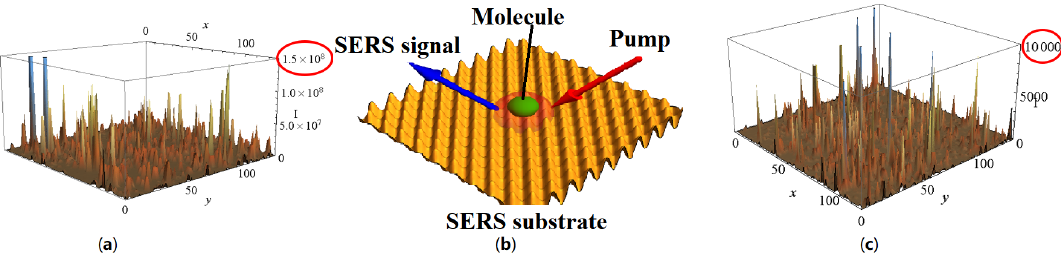
Figure 5. Schematic picture of SERS effect, see ( b ); incident light excites the collective plasmon field in semicontinuous metal film (see c ), primary field); Raman active molecules, being pumped by the primary electric field, excite secondary EM field at the Stokes shifted frequency, see ( a